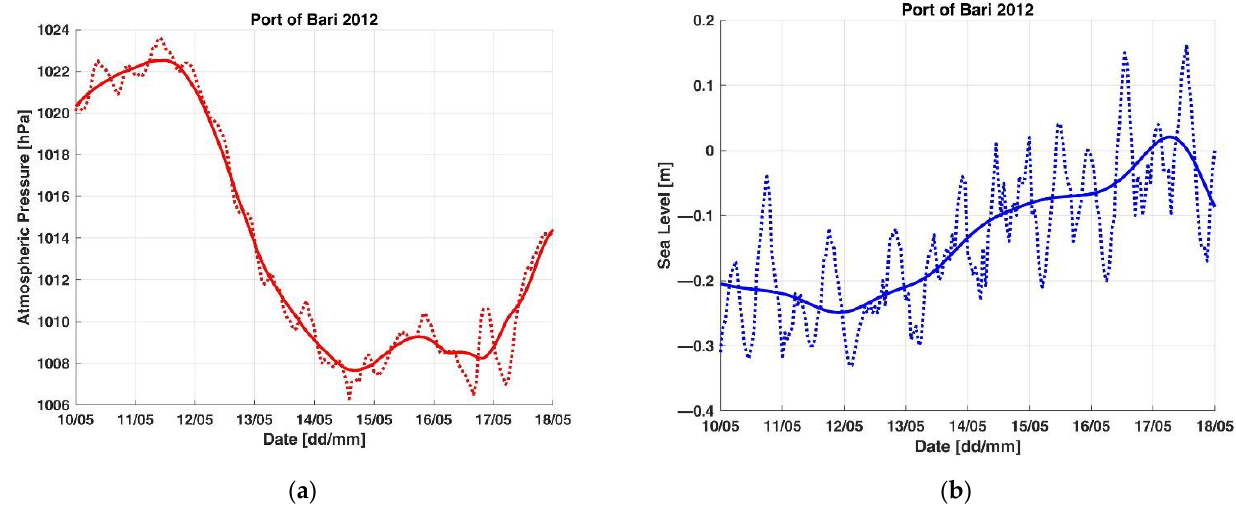
Figure A14. Low-frequency components of meteo-mareographic parameters acquired by ISPRA’s monitoring station in the port of Bari from 10 to 18 May 2012: ( a ) atmospheric pressure; ( b ) sea level.